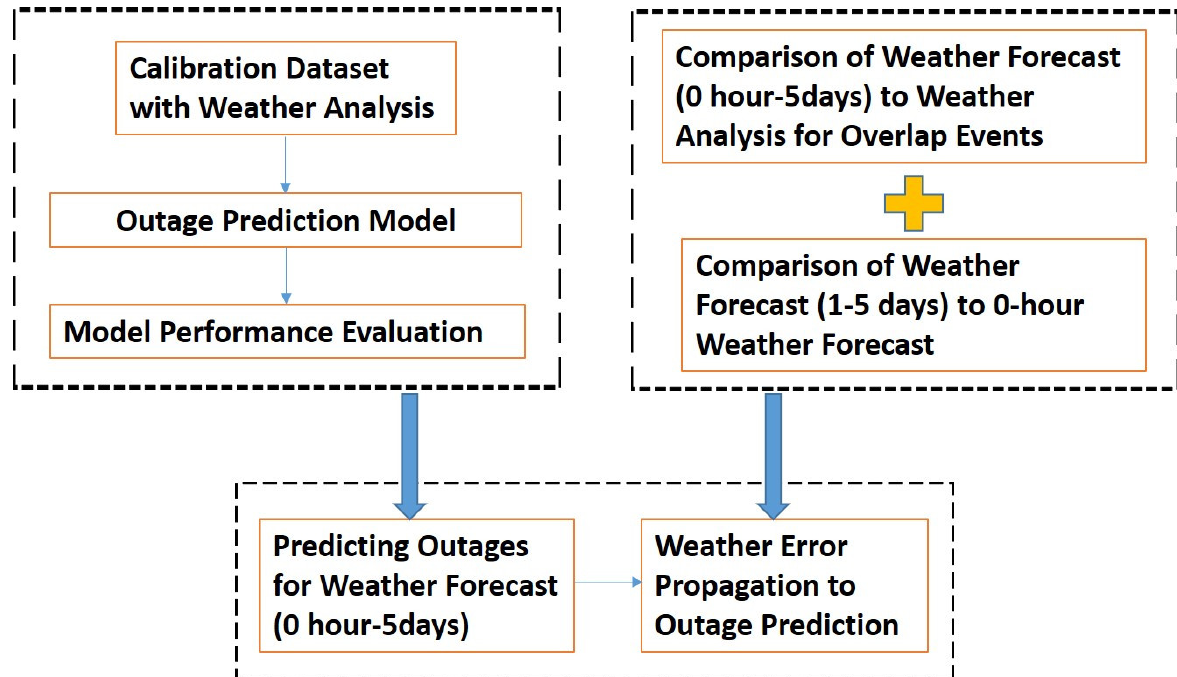
Figure 1. Flowchart of methodology.